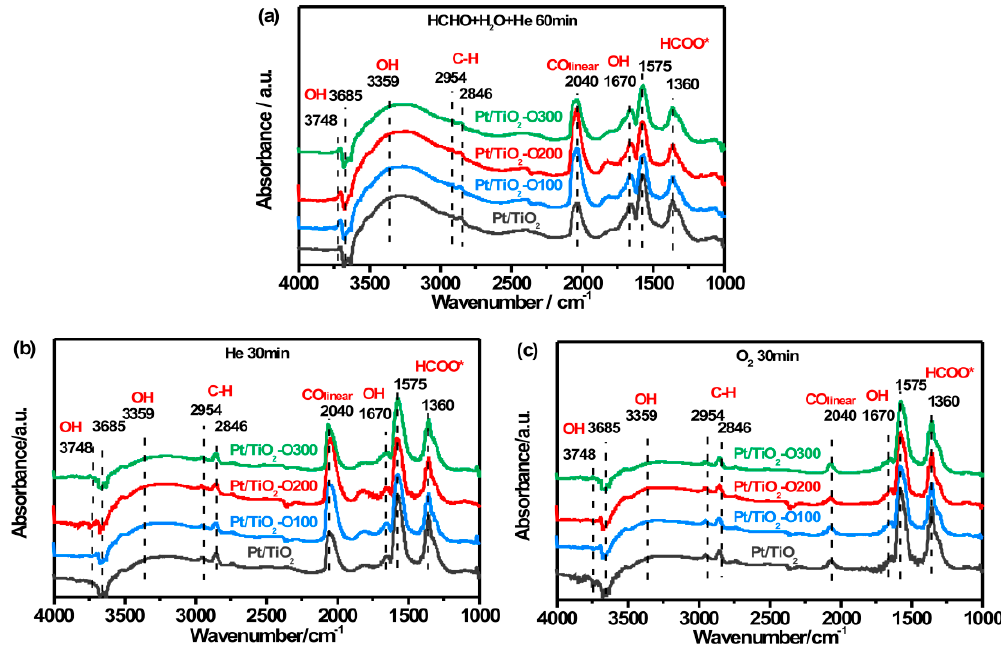
Figure 7. HCHO-DRIFT profiles of various pre-oxidized Pt / TiO 2 catalysts and pristine Pt / TiO 2 after ( a ) a flow of He + HCHO + H 2 O for 60 min, ( b ) He purging for 30 min, and finally ( c ) O 2 purging for 30 min.